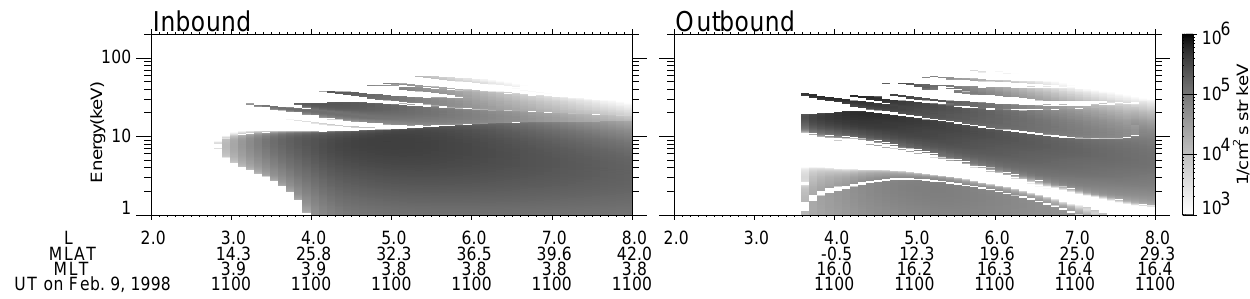
Fig. 3. Same as panels 9 and 10 of Fig. 1, except that time is fixed to 11:00UT on 9 February 1998.